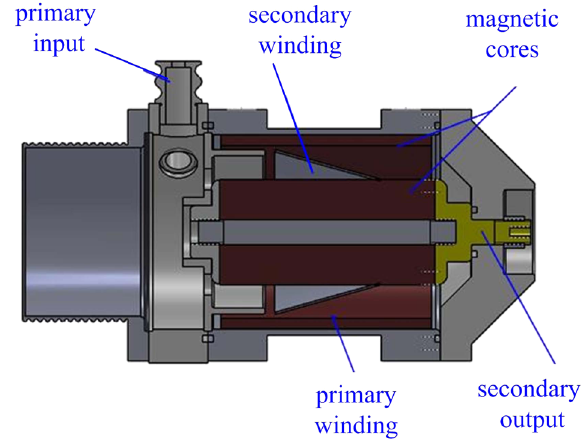
FIG. 3. Photograph of the pulse transformer. FIG. 4. Diagram of the cross section of the pulse